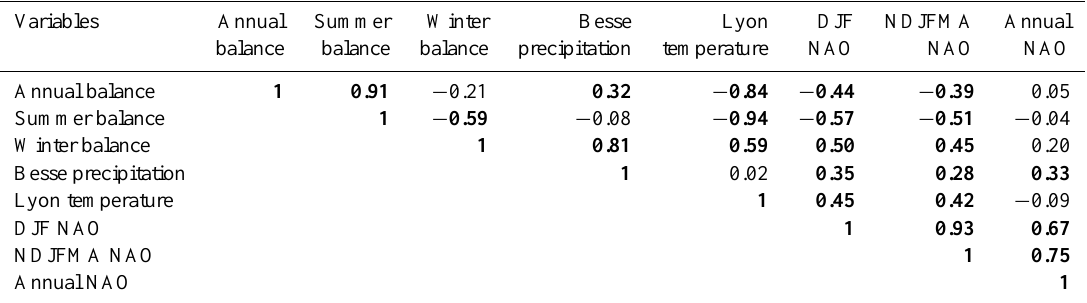
Table 3. Correlation matrix between trends in the different time series. Bold face values are significant non-zero correlations at the 95% confidence level. All trends are provided by the variance decomposition model of Eq. (2), apart from trends in NAO anomalies resulting from the 7-yr triangular moving averages. Besse precipitations are winter cumulative precipitations between Sarennes field visits. Lyon temperatures are May–October daily